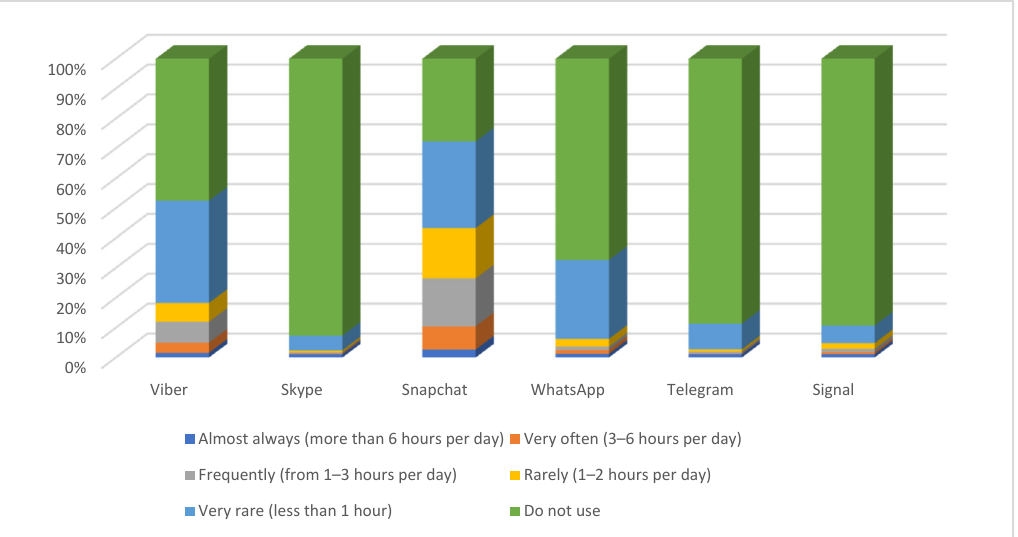
Figure 4. Exposure to chat services.